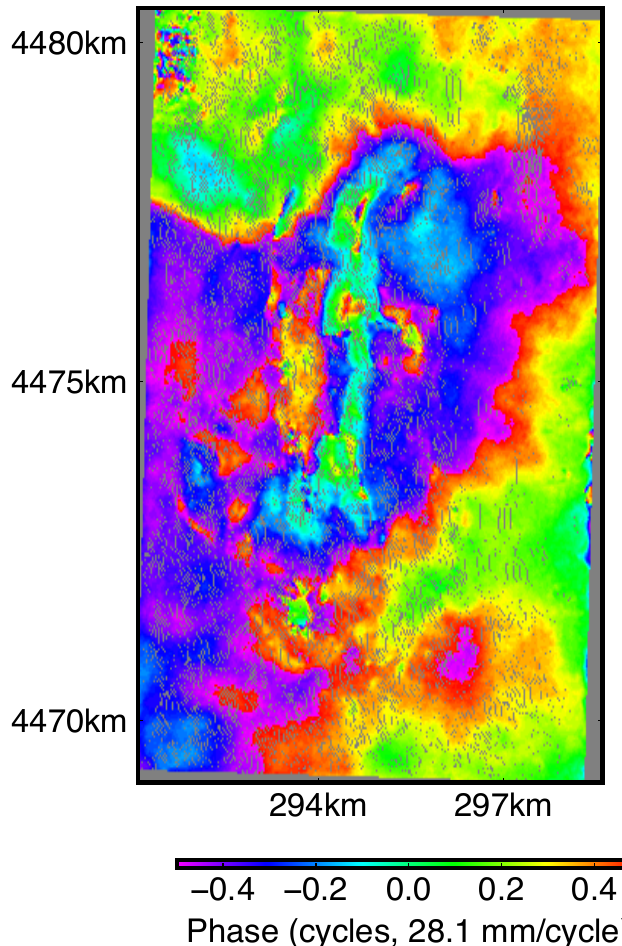
Figure A5. Deformation field at San Emidio in terms of wrapped range change in cycles from an Envisat track 27 pair spanning 22nd July 2009 to 30th September 2009. One cycle of wrapped phase corresponds to a range change of approximately 28 mm. Orbital baseline b ⊥ = − 57.6 m and temporal baseline ∆ t = 70 days. Coordinates are easting and northing kilometers in UTM projection zone 11N, WGS84